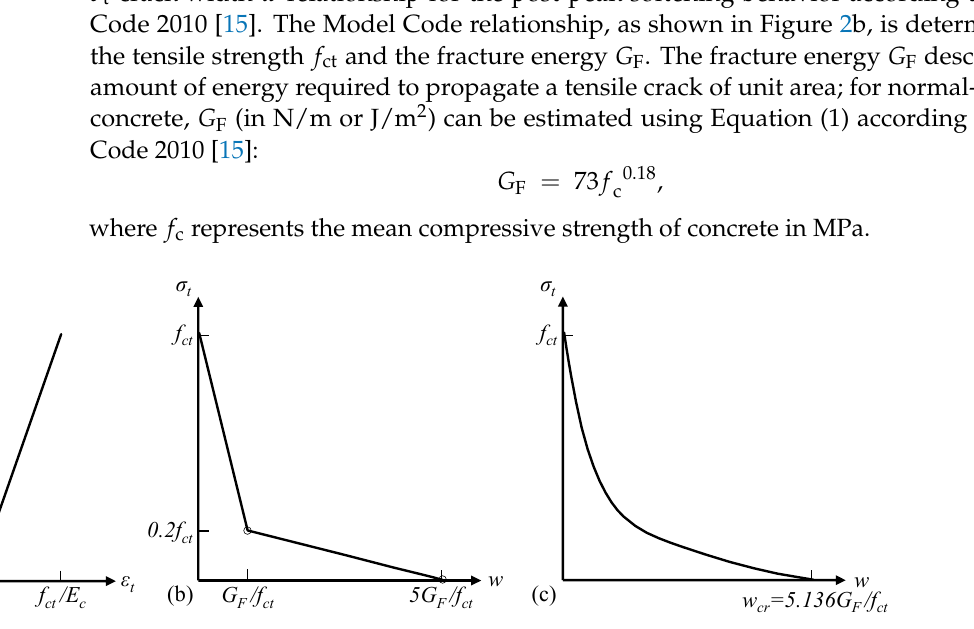
Figure 2. Constitutive models for concrete in tension: ( a ) linear elastic stress–strain relationship for uncracked concrete; ( b ) bilinear tensile stress–crack width relationship according to Model Code 2010 [15]; ( c ) exponential tensile stress–crack width relationship proposed by Hordijk [43].